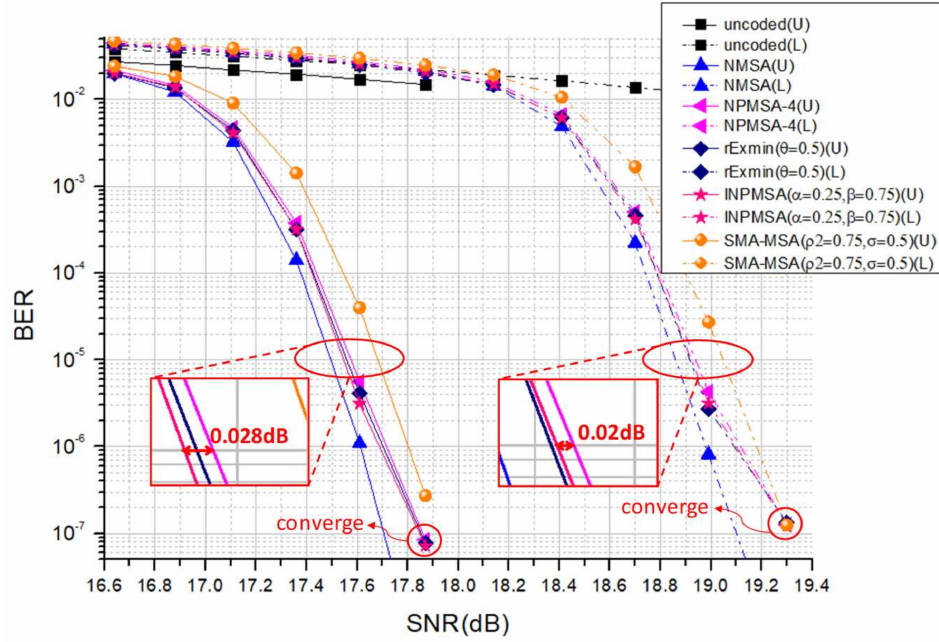
Figure 3. Simulation results of different algorithms in the NAND flash channel